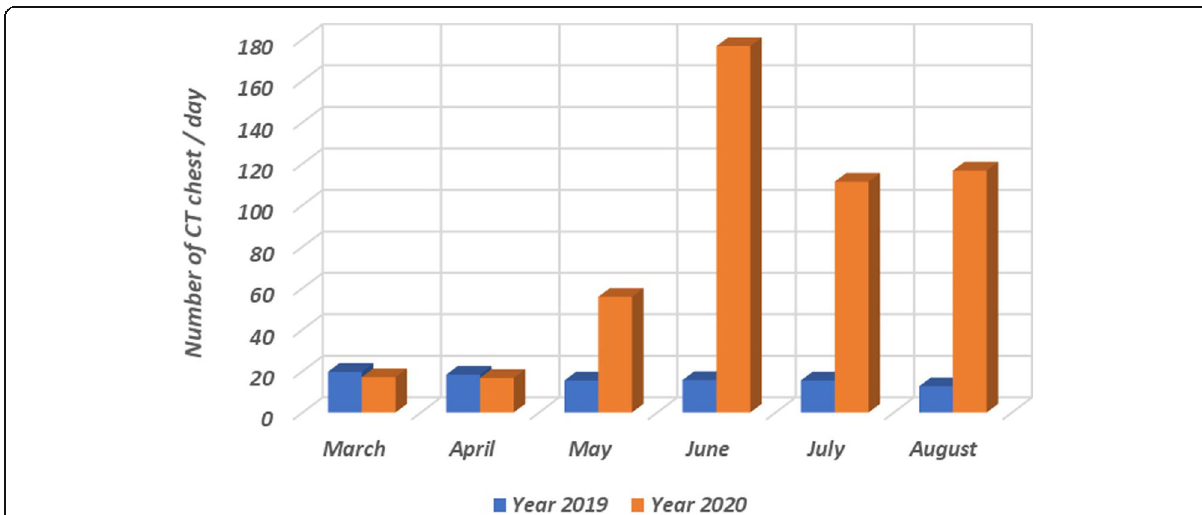
Fig. 3 Bar graph demonstrating the average number of chest CT performed per day from March to August in 2020 compared to the number of examinations in the same period last